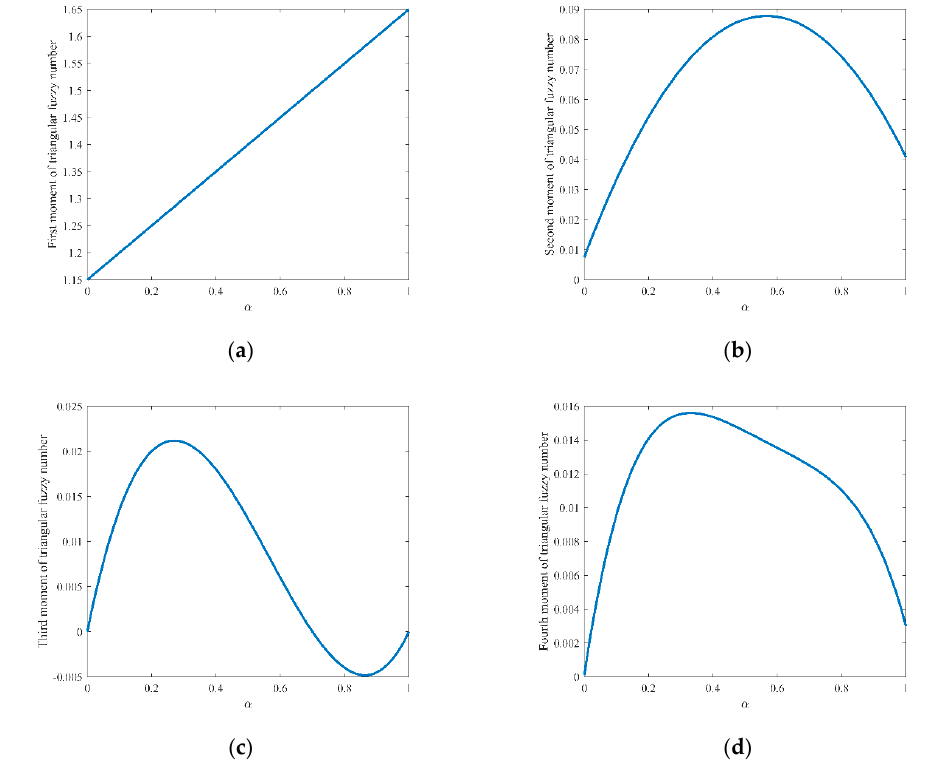
Figure 2. Four moments of the triangular fuzzy variables ( a ) The first-order moment (mean); ( b ) Second-order moment (variance); ( c ) Third-order moment (skewness); ( d ) Fourth-order moment (kurtosis).